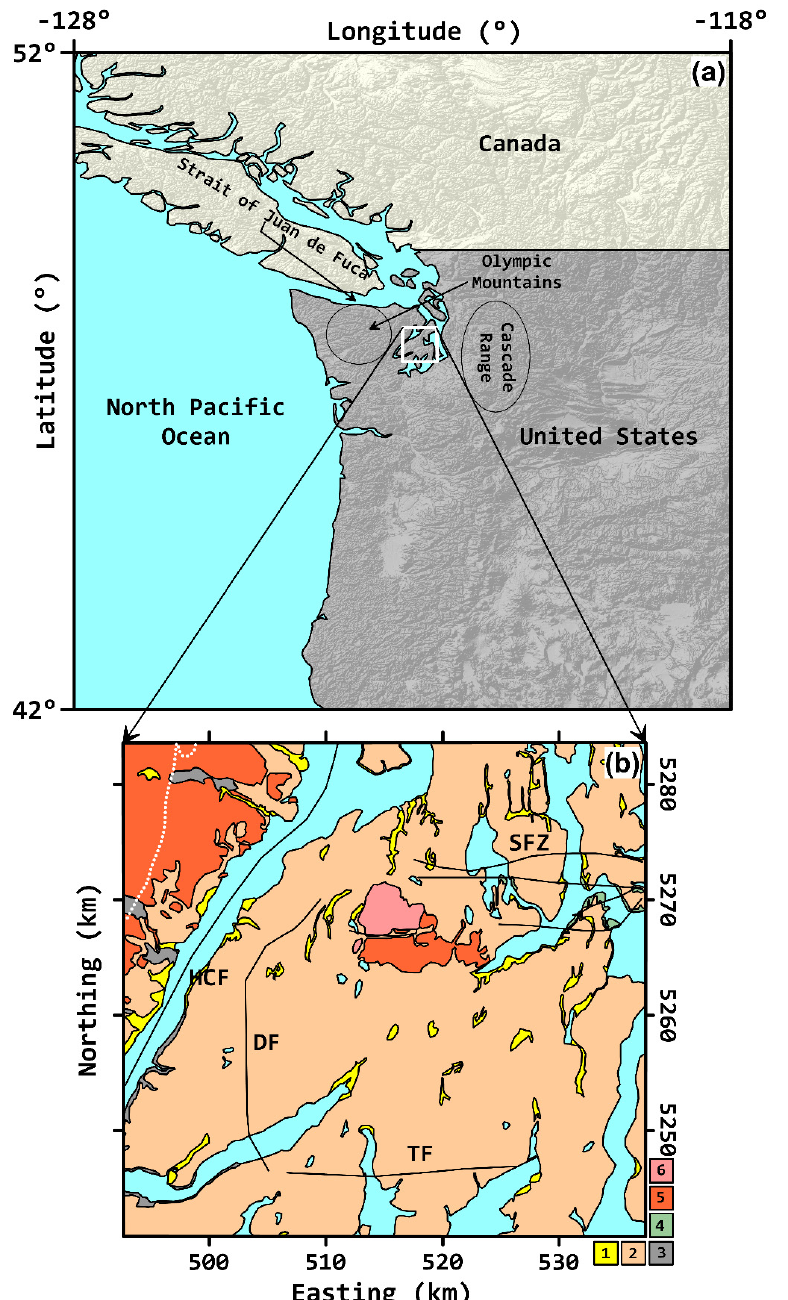
Figure 9. ( a ) Location map of the study region near Seattle Uplift over the topography; ( b ) Geology and tectonic settings of the region. The abbreviations of various geological units are as follows: 1. Quaternary deposits, 2. Pleistocene continental glacial deposits, 3. Pleistocene alpine glacial deposits, 4. Paleogene-Neogene marine sedimentary rocks, 5. Paleogene-Neogene intrusive rocks, 6. Eocene Crescent Formation. The solid black lines are the tectonic faults in the study region. The abbreviations of the tectonics are HCF: Hood Canal Fault, DF: Dewatto Fault, TF: Tacoma Fault, SFZ: Seattle Fault Zone. The major structures are extracted from [31,34].